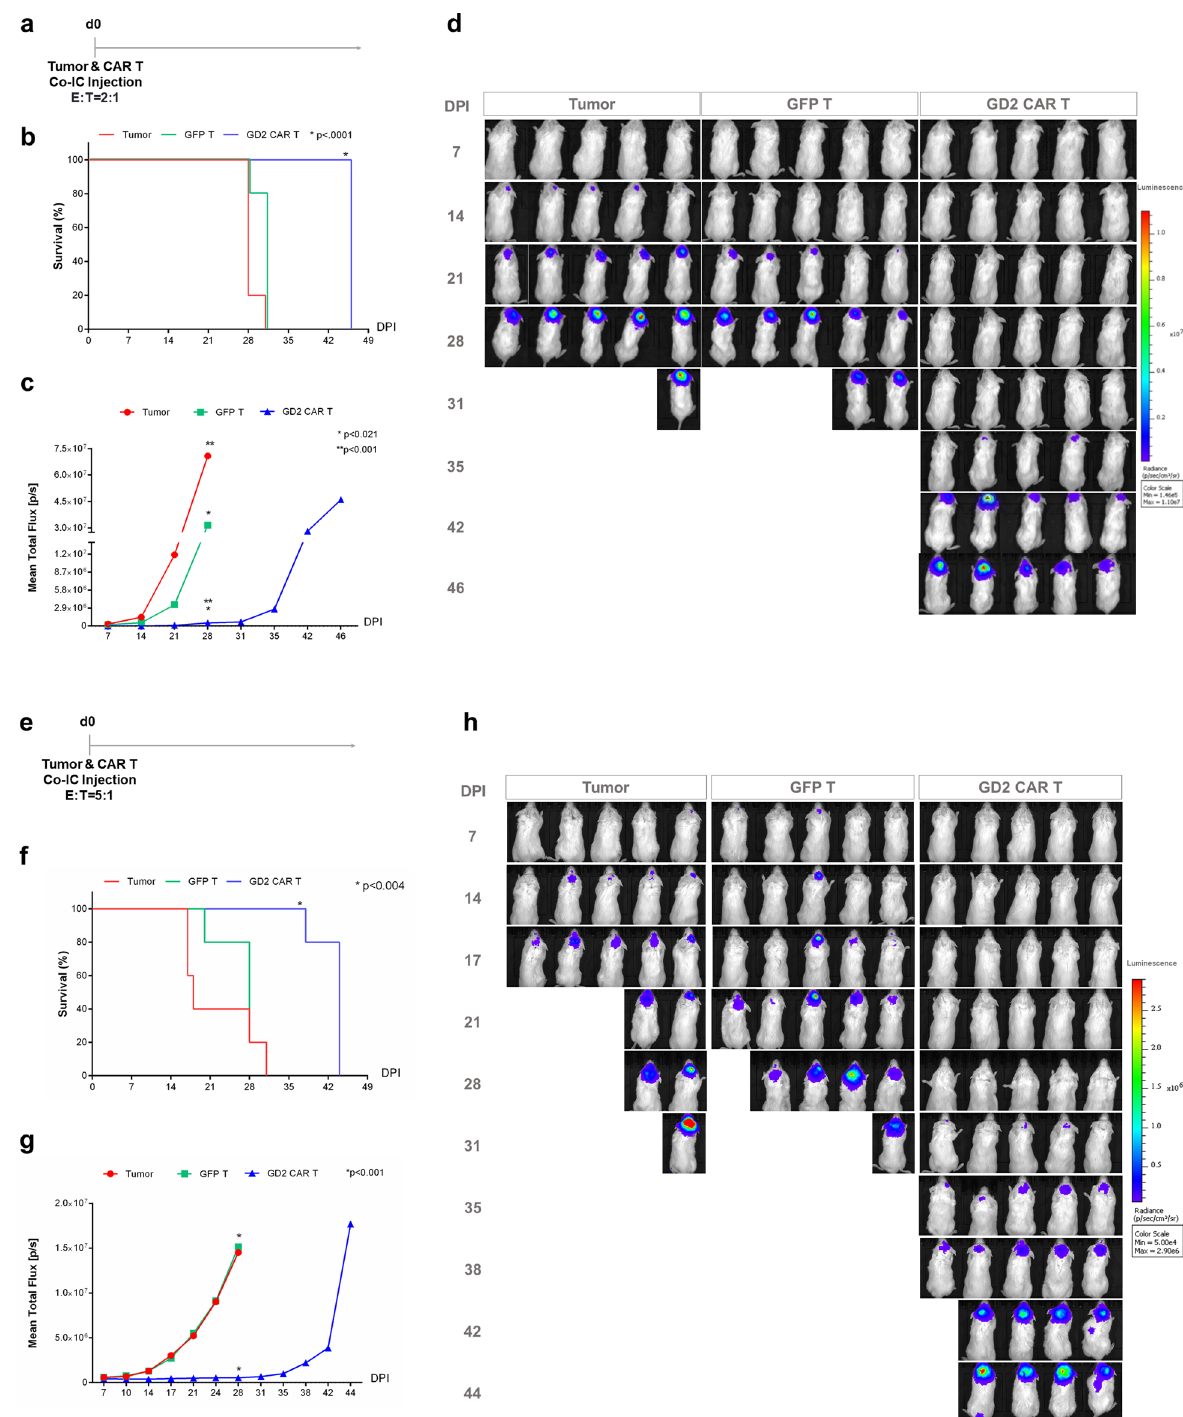
Fig. 8 Intracerebral GD2 CAR T cell treatment improves survival in the orthotopic glioblastoma model. a Schematic outline of CAR T treatment by intracerebral (IC) co-injection. NOD/SCID mice ( n = 5) are co-injected intracranially with 1 × 10 5 C12.FFLuc cells and 2 × 10 5 of either GD2 CAR T cells or GFP control T cells at day 0. b Kaplan – Meier survival curve and log-rank tests are used to measure differences among groups. c Mean total fl ux values (photons/s) of either GD2 CAR T or GFP T control-treated mice and control animals monitored by IVIS system. Data are shown as a mean ± SD; p values are calculated by unpaired two-tailed t -test. d Tumor progression is monitored weekly by a luminescence signal with IVIS imaging measuring. DPI day post-injection. e Schematic outline of CAR T treatment by intracerebral (IC) co- injection. NOD/SCID mice ( n = 5) are IC co-injected with 1 × 10 5 C12.FFLuc cells and 5 × 10 5 of either GD2 CAR T cells or GFP control T cells at day 0. f Kaplan – Meier survival curve and log-rank tests are used to measure differences among groups. g Mean total fl ux values (photons/s) of either GD2 CAR T or GFP T control-treated mice and control animals monitored by IVIS system. Data are shown as a mean ± SD; p values are calculated by unpaired two-tailed t -test. h Tumor progression is monitored weekly by a luminescence signal with IVIS imaging measuring. DPI day